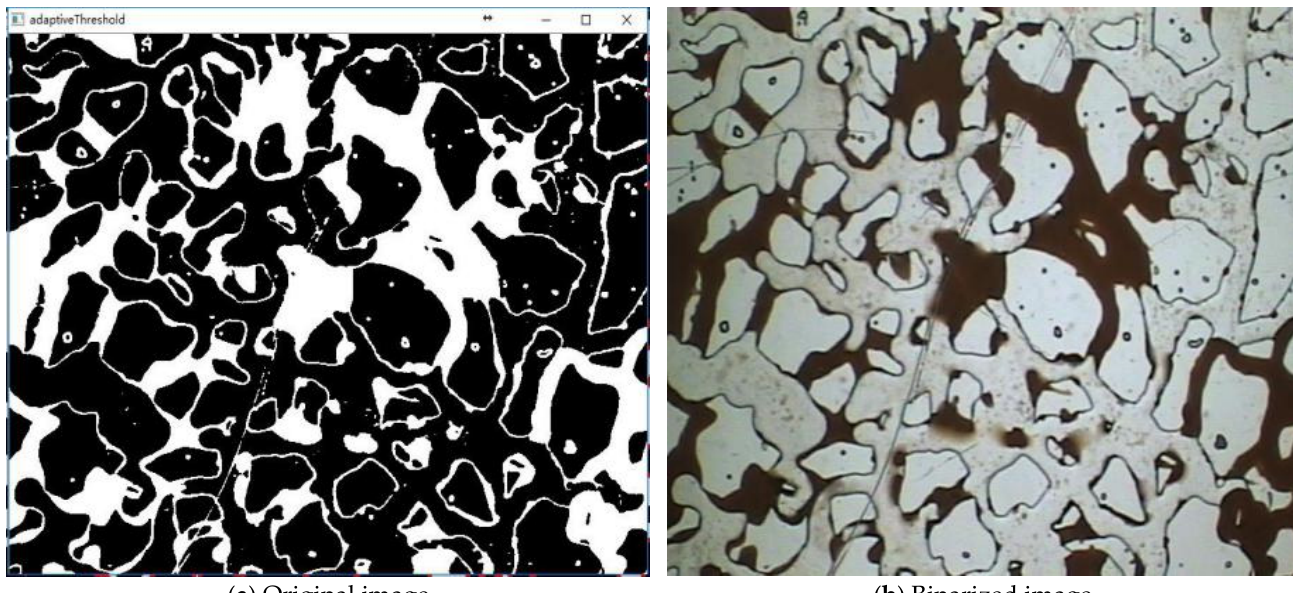
Figure 4. Effect comparison before and after binarization.